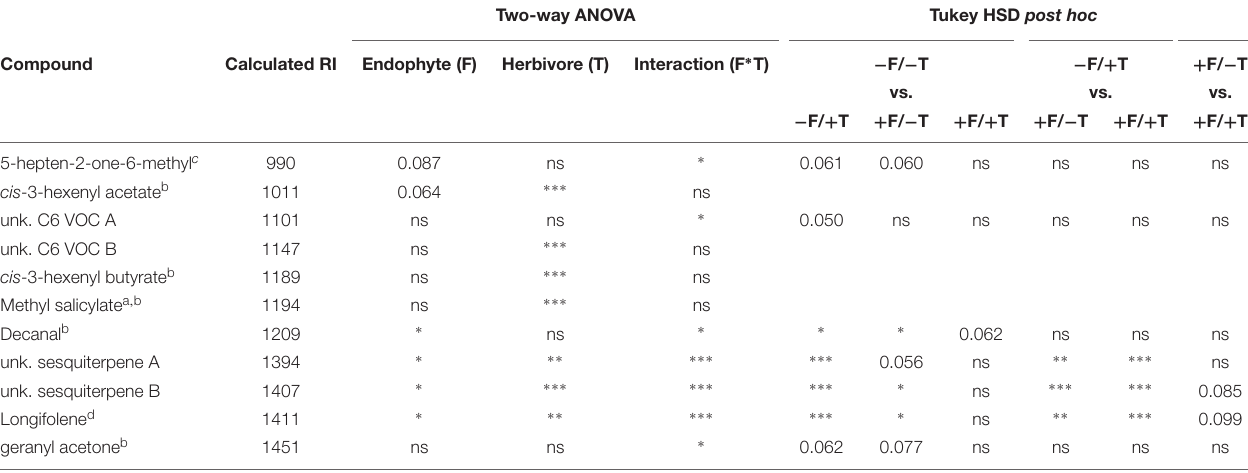
TABLE 1 | Volatiles emitted by tomato plants according to their calculated Kovats retention index (RI).